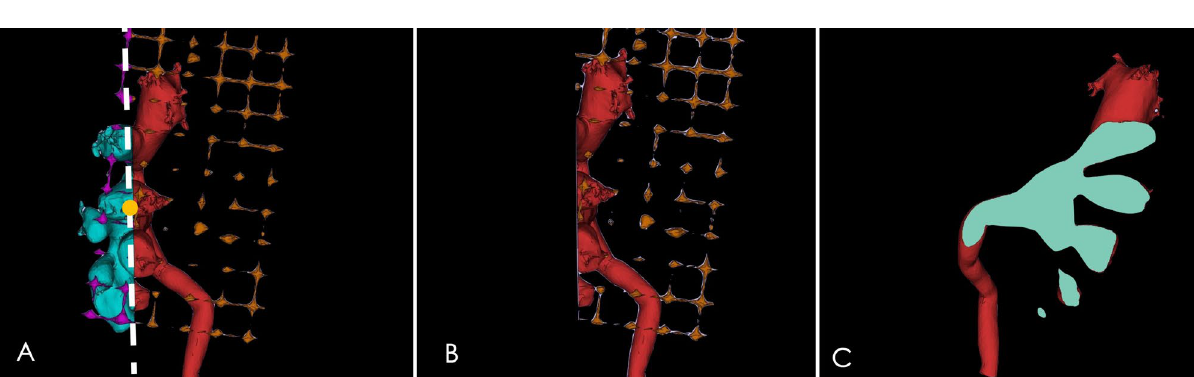
Figure 5. Segmentation of the optimal simulated ultrasonography-guided section of the targeted renal calyx. ( A , B ) The section was segmented through the axis of the targeted renal calyx and as close as possible to the axis of the adjacent posterior renal calyx (white line segment). ( C ) Segmented section C (cyan, outlined) shows the targeted renal calyx, renal pelvis, and surrounding renal calyces. The figure was edited with Magics 20.03 (https:// www. mater ialise. com).